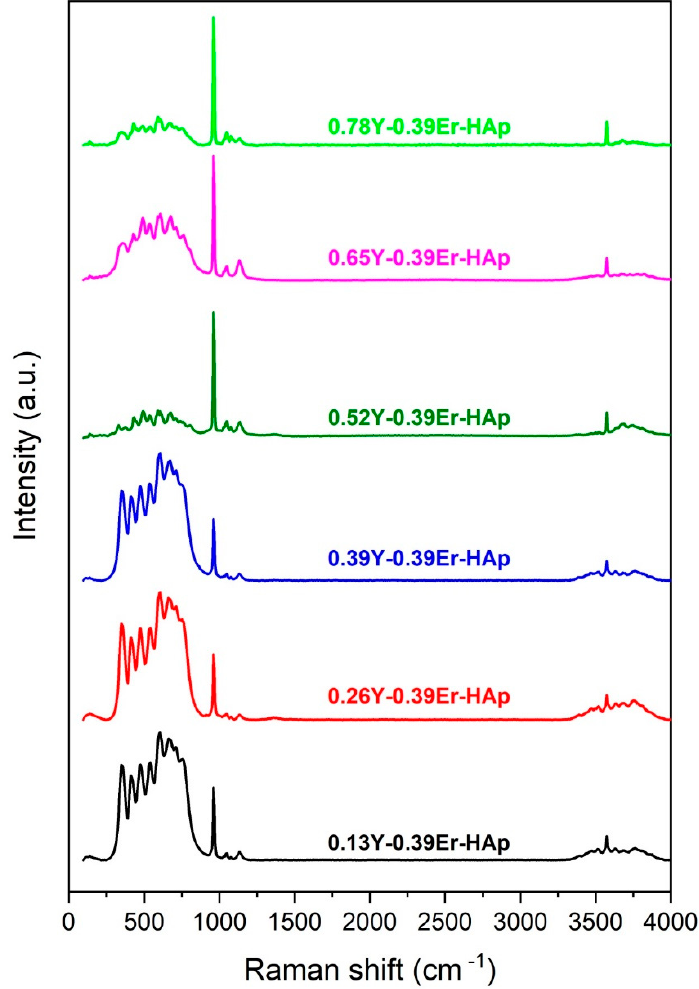
Figure 4. Raman spectra of the as-synthesized HAps.